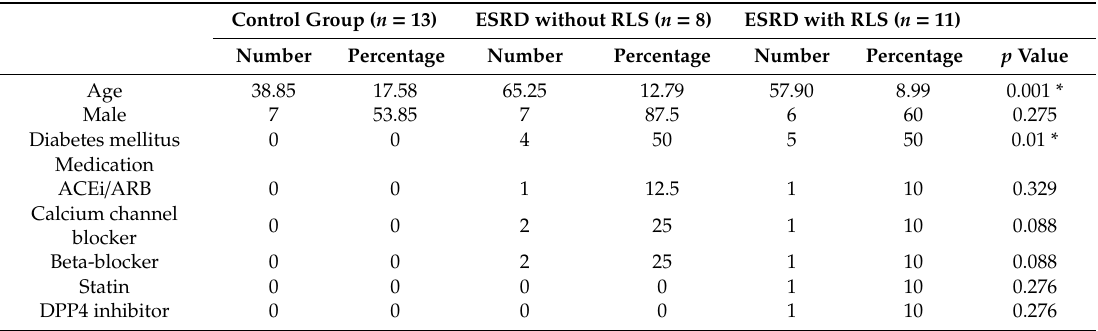
Table 1. Demographics of patients. ACEi / ARB: angiotensin-converting enzyme inhibitor / angiotensin receptor blockade. DPP4 inhibitor: dipeptidyl peptidase-4 inhibitor.